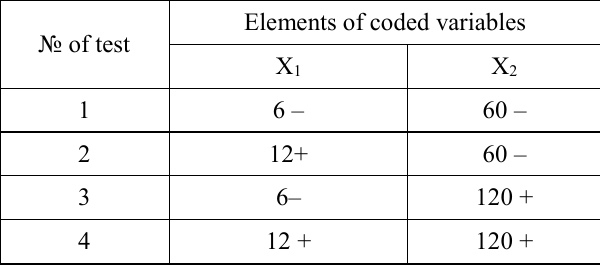
Matrix of factorial experiment (type 2- 2 ) for studying of influence of quantity of repetitions (Х 1 ) and rest intervals (Х 2 ) in one lesson on training of 14-15 years’ age pupils.